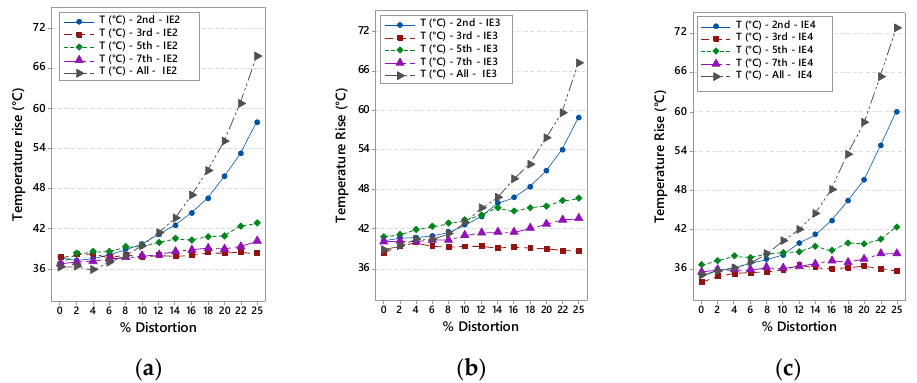
Figure 11. Temperature rise in the presence of voltage harmonics of 2nd, 3rd, 5th, 7th and all harmonic order combined for induction motors ( a ) IE2 SCIM; ( b ) IE3 SCIM; ( c ) IE4